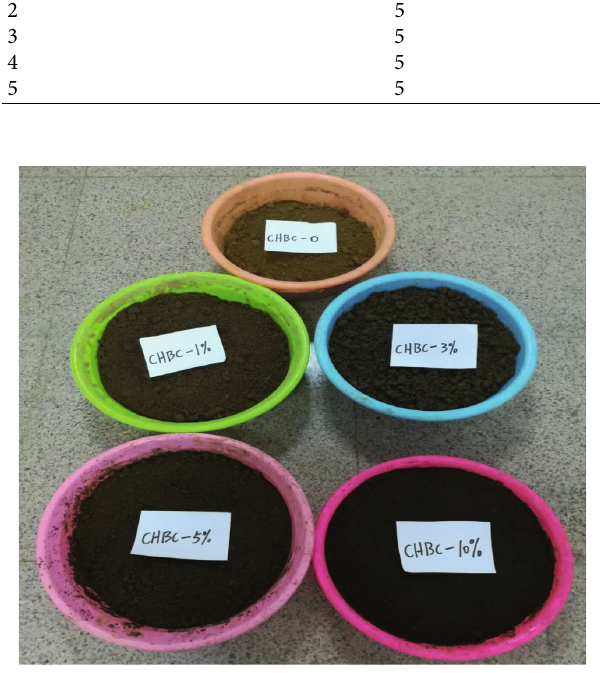
Figure 3: Picture of Cr(VI)-contaminated soil stabilized by CHBC.